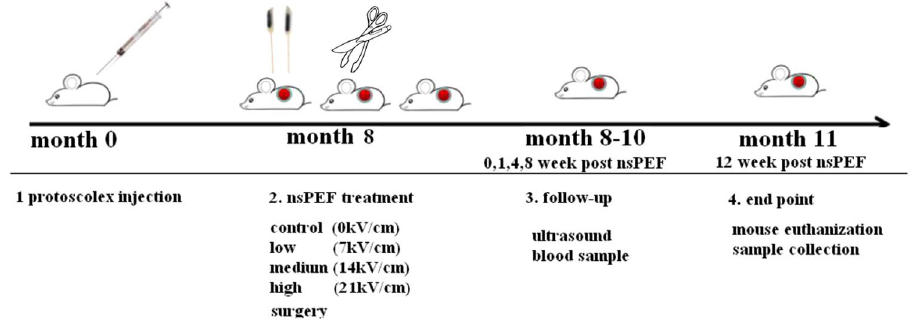
Figure 1. Experiment time course and interventions on animals. It took total of 12 months to complete the animal experiment which include two stages: (1) The protoscolex injection in portal vein. (2) nsPEF treatment. (3) post-treatment follow up and (4) end point to euthanize the animal and collect samples.